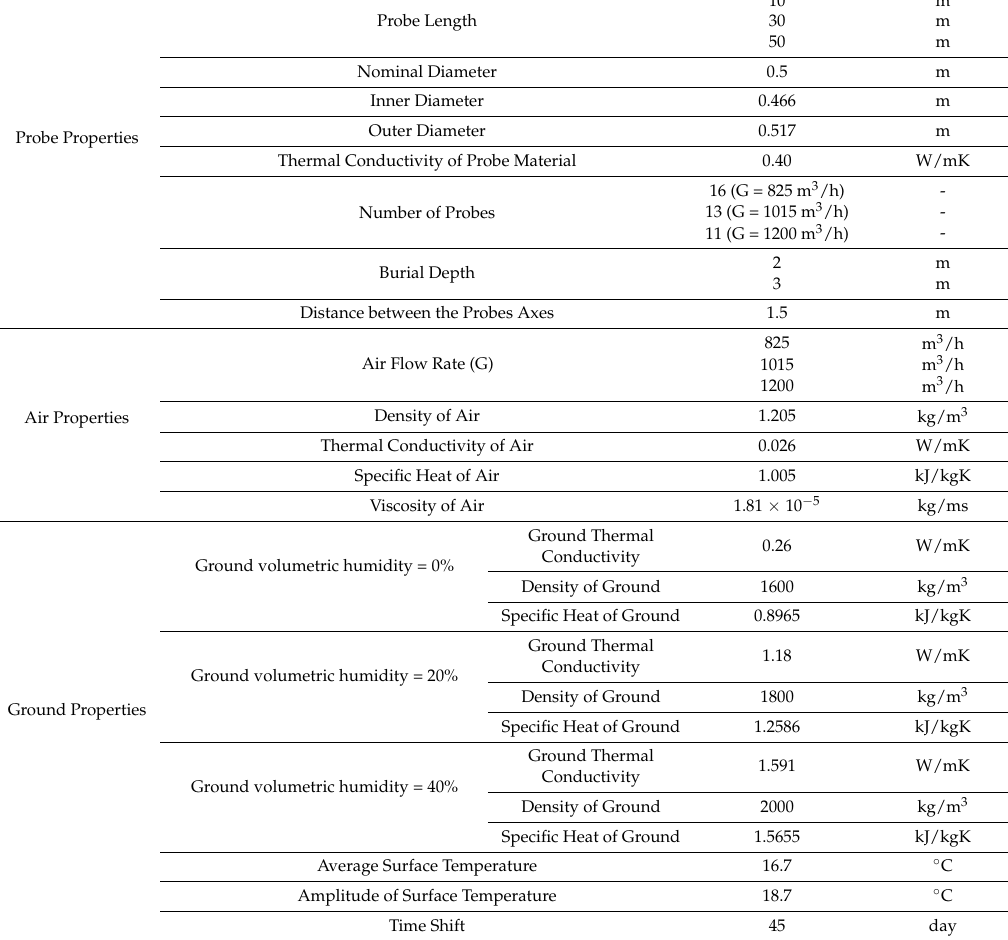
Table 1. Configuration parameters for HAGHE